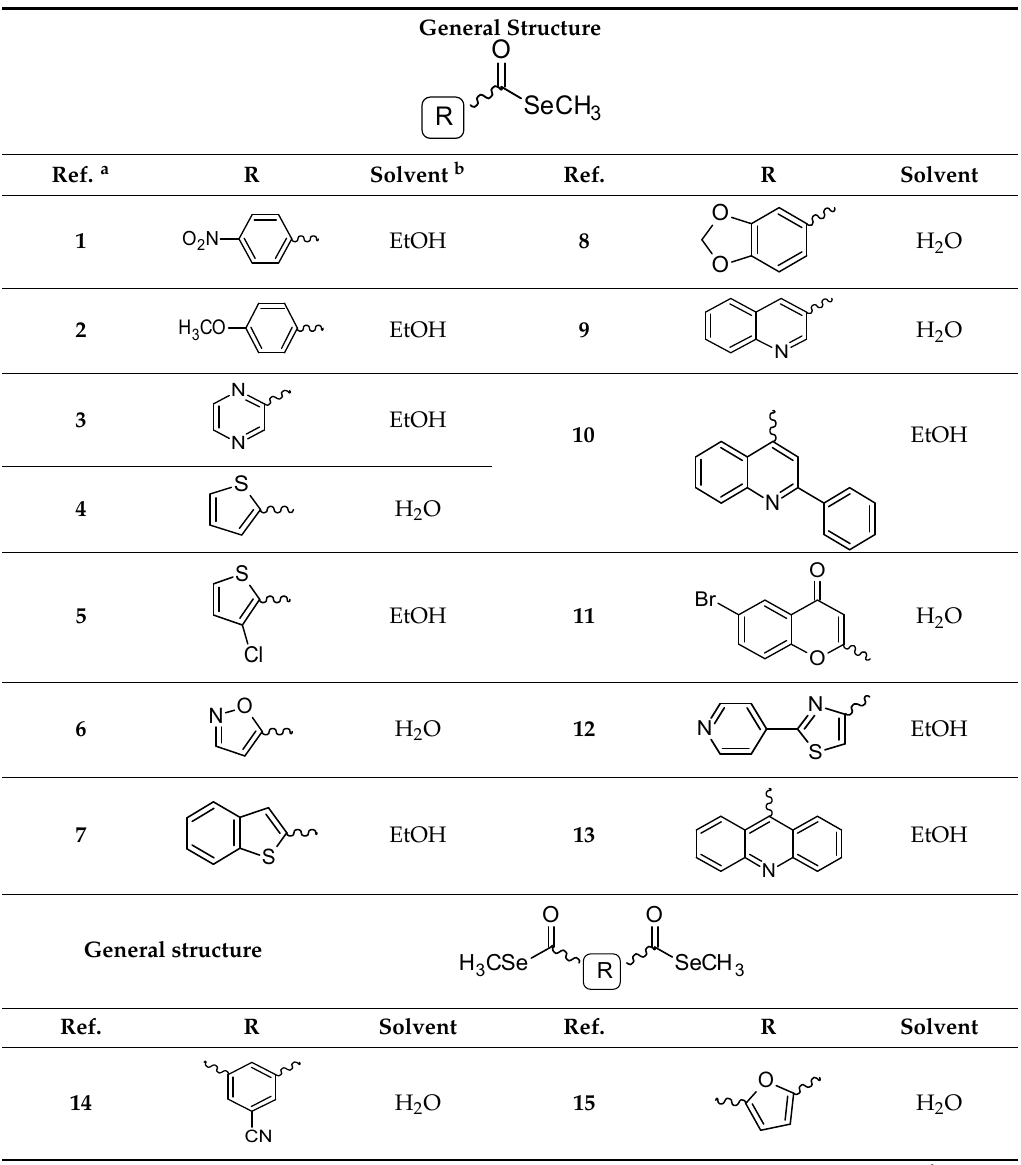
The wavy bond indicates the attachment position for the methylselenoester moiety. a Compound reference; b Solvent used as reaction medium.